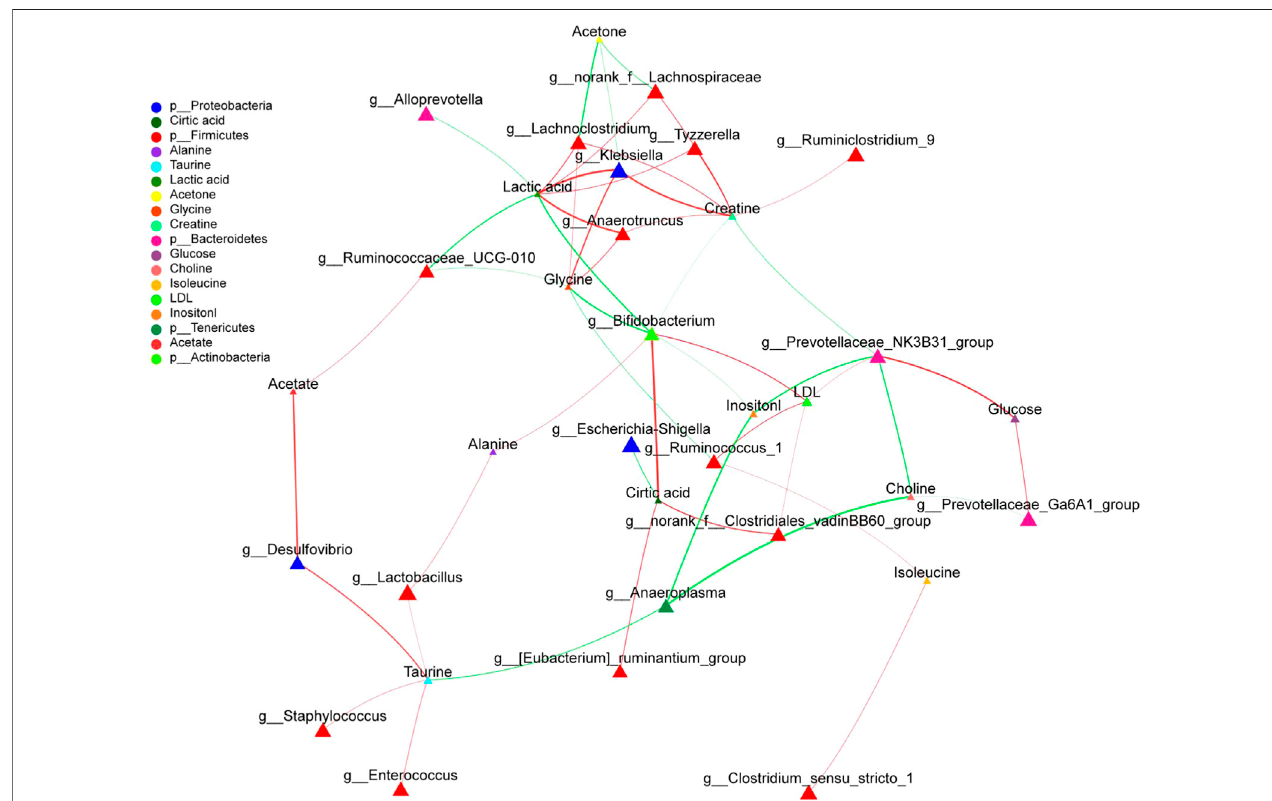
FIGURE 11 | Network analysis of the abundances of gut microbiota and serum metabolites.network analysis. The fi gure shows p < 0.05, correlation > 0.5, the top 50 species abundance. The size of the nodes indicates the abundance of the species, and different colors indicate different species. The color of the line indicates positive (red) and negative (green)